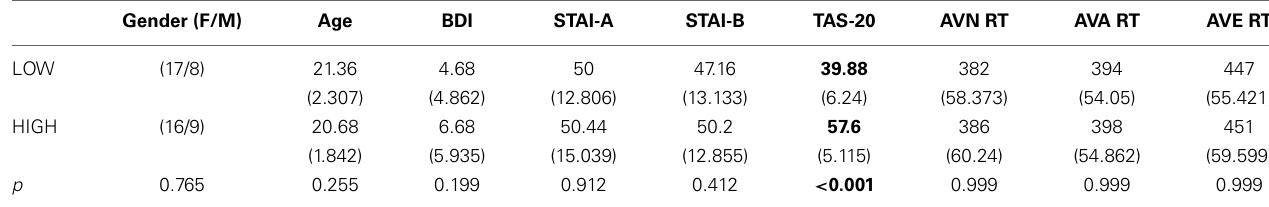
Table 5 | Means and standard deviations (in parentheses) of the low group (LOW) and high (HIGH) groups’ scores for age, BDI and STAI and TAS-20 psychological tests, and reaction times (ms) for the 3 conditions.